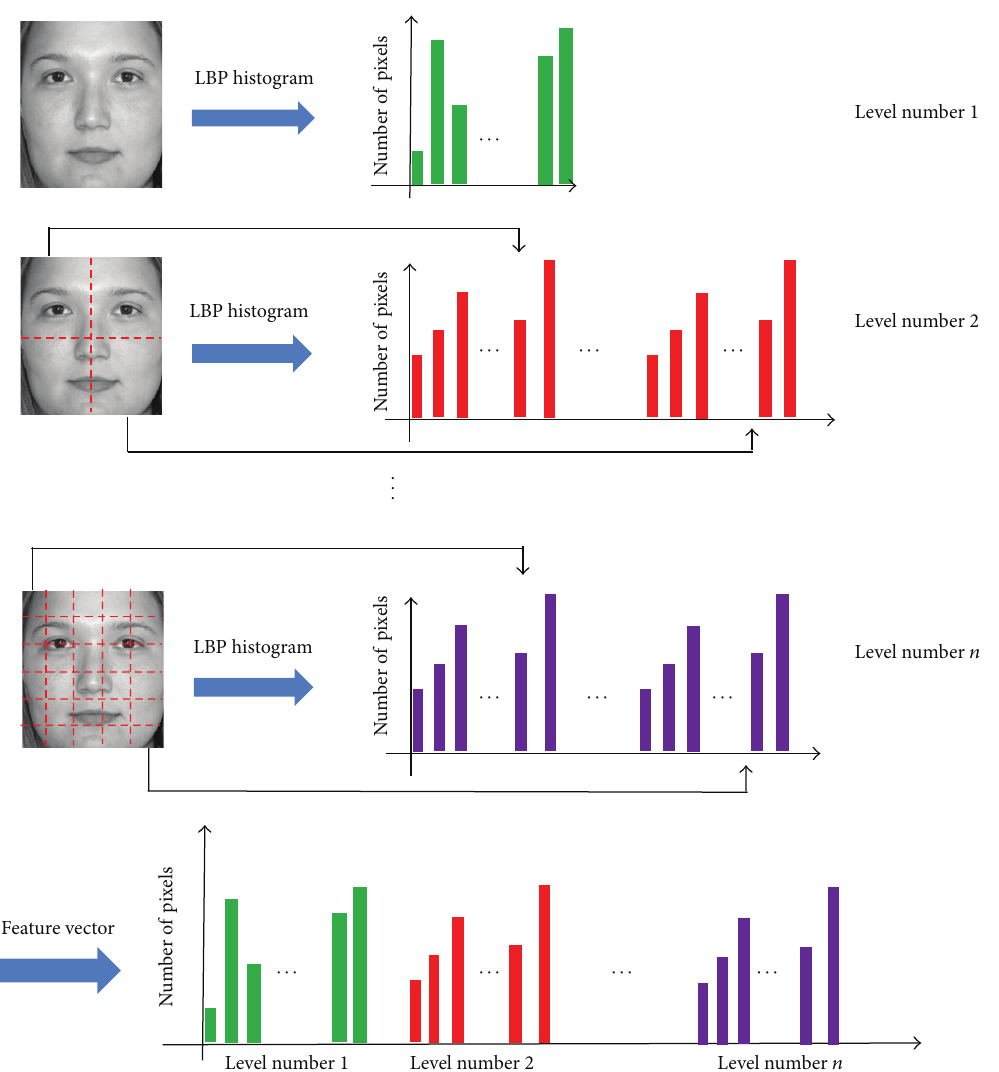
Figure 9: Method for constructing MLBP feature vector from multiple single-level LBP feature vectors.